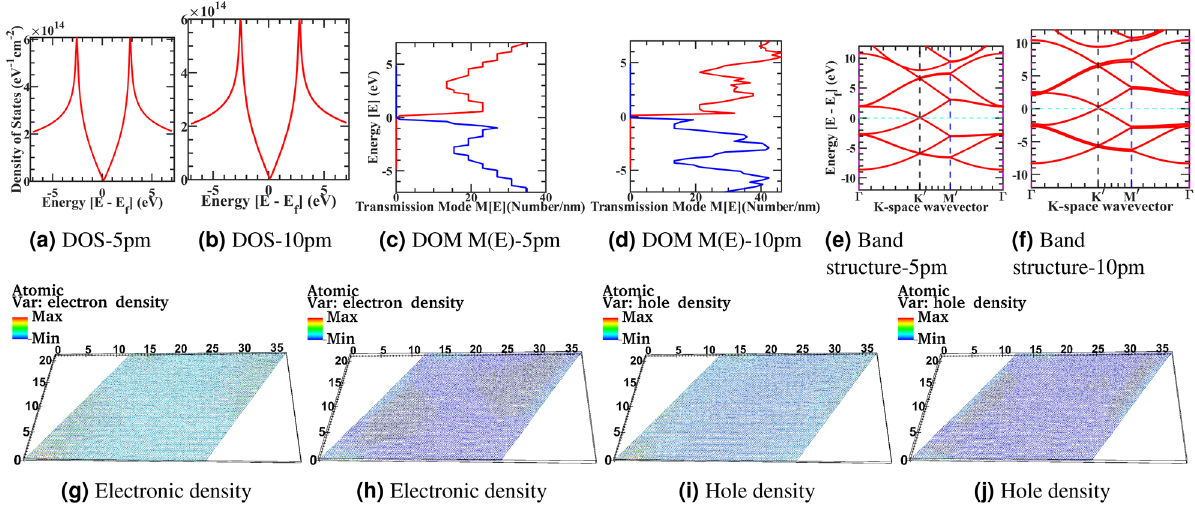
Figure 2. Device structure 100x100 graphene supercell with surface corrugation 5pm and 10pm, and respectively Density of state ( a , b ), Electronic density of modes M(E) in x-y Direction ( c , d ), Electronic band structure ( e , f ), Electronic density ( g , h ), and Hole density ( i , j ).